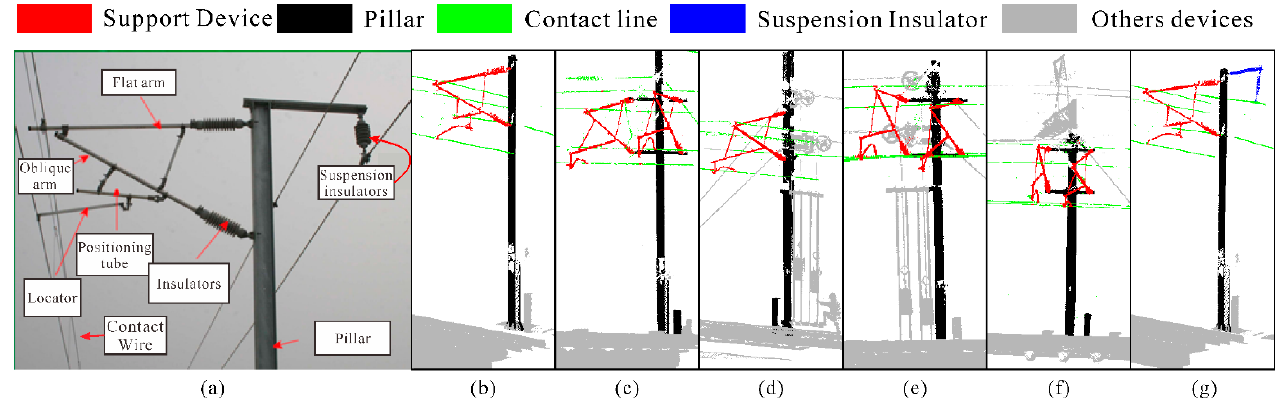
( c ) Figure 6. Experimental datasets. ( a ) Railway dataset from Yancheng to Nantong. ( b ) Z + F Profile 9012. ( c ) GNSS track acquisition device.